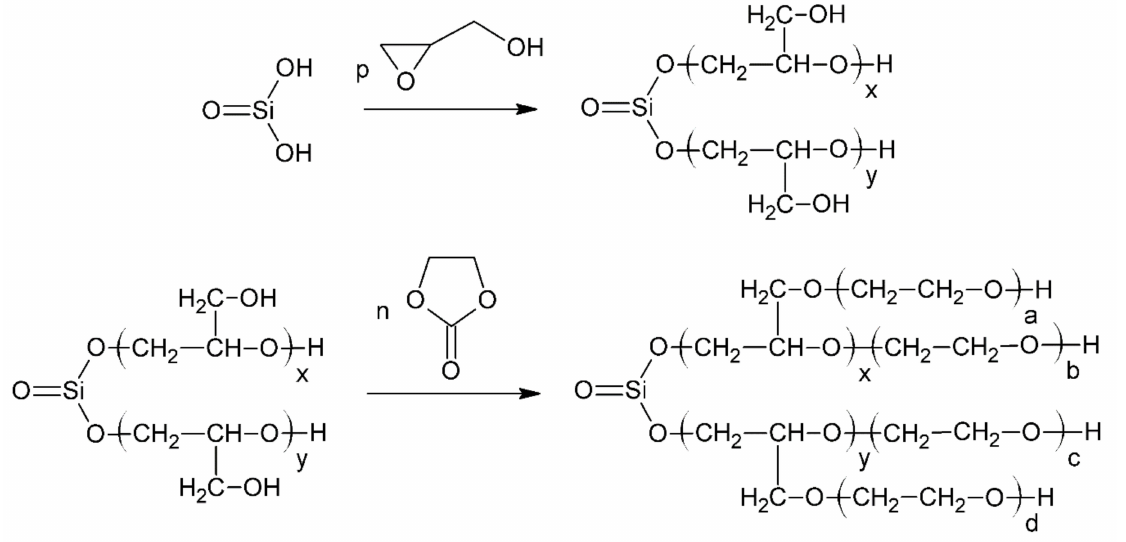
Figure 10. Scheme of synthesis of polyol based on metasilicic acid (where: p = x + y and n = xa + b + c + yd).